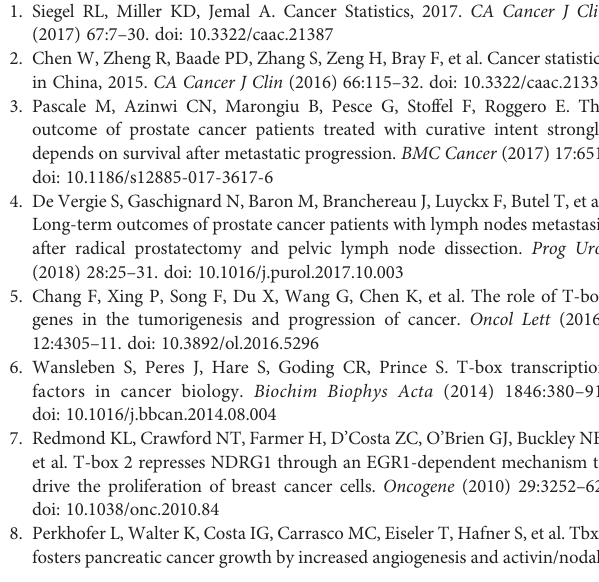
SUPPLEMENTAL FIGURE 1 | Genes differentially expressed in correlation with TBX1 in PCa (LinkedOmics). Left, the correlations between TBX1 and genes differentially expressed was analyzed using the Pearson test; Middle, the TOP 50 genes positively correlated with TBX1 were shown using the heat map; Right, the TOP 50 genes negatively correlated with TBX1 were shown using the heat map. The red color represents positively correlated genes and the green color represents negatively correlated genes. Prostate cancer,